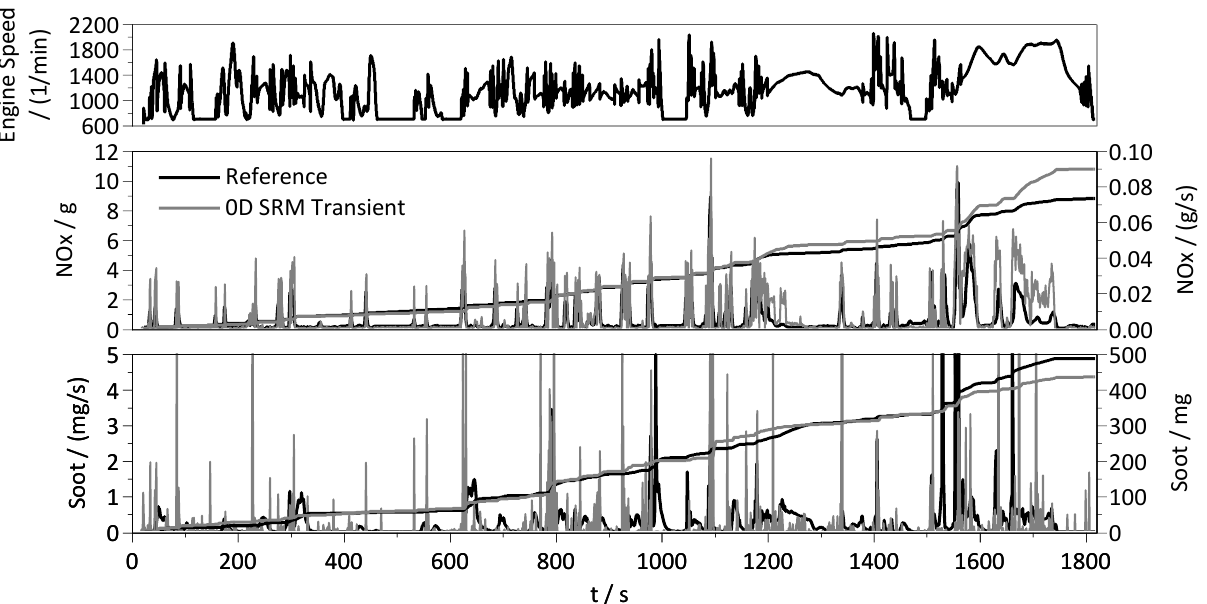
Figure 10. Comparison of the NOx and soot mass flows, as well as cumulative values, between simulation and reference measurements.